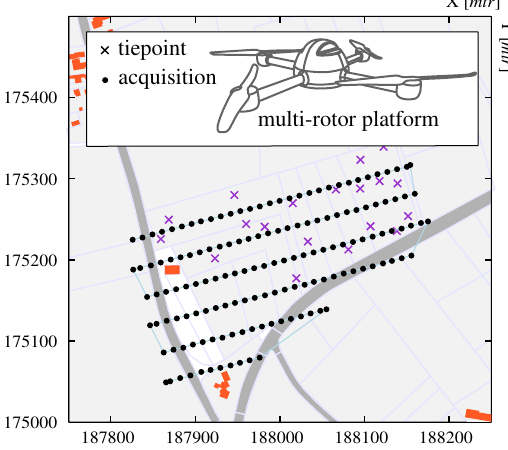
Figure 2: Large scale map, in Lambert 72 projection, illustrating the neighborhood of the site. The black dots (148) indicate the position of the UAV when a photo was taken. The crosses illus- trate the used ground-points for its